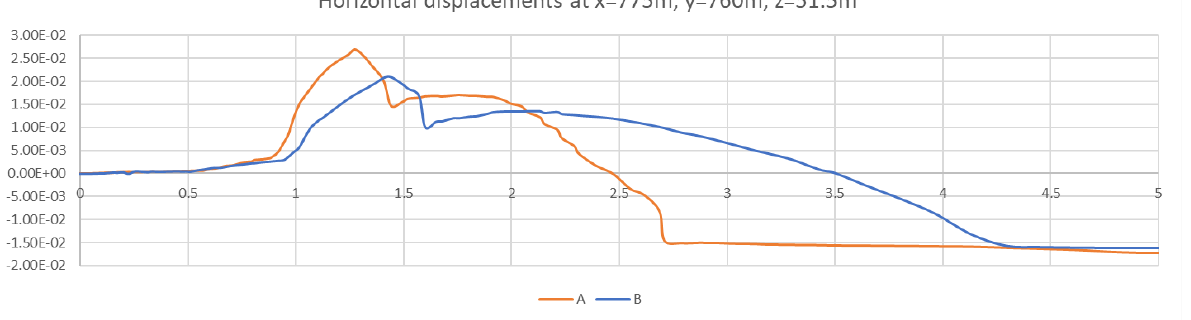
Horizontal displacements are small compared to vertical displacements. Similar to the vertical displacements, the greatest values of displacements caused by temperature are reached in the layer of clays displacement vectors in cross-section z = 51.5 at time t = 1.5 year (greatest displacements) is shown in fig. 11.